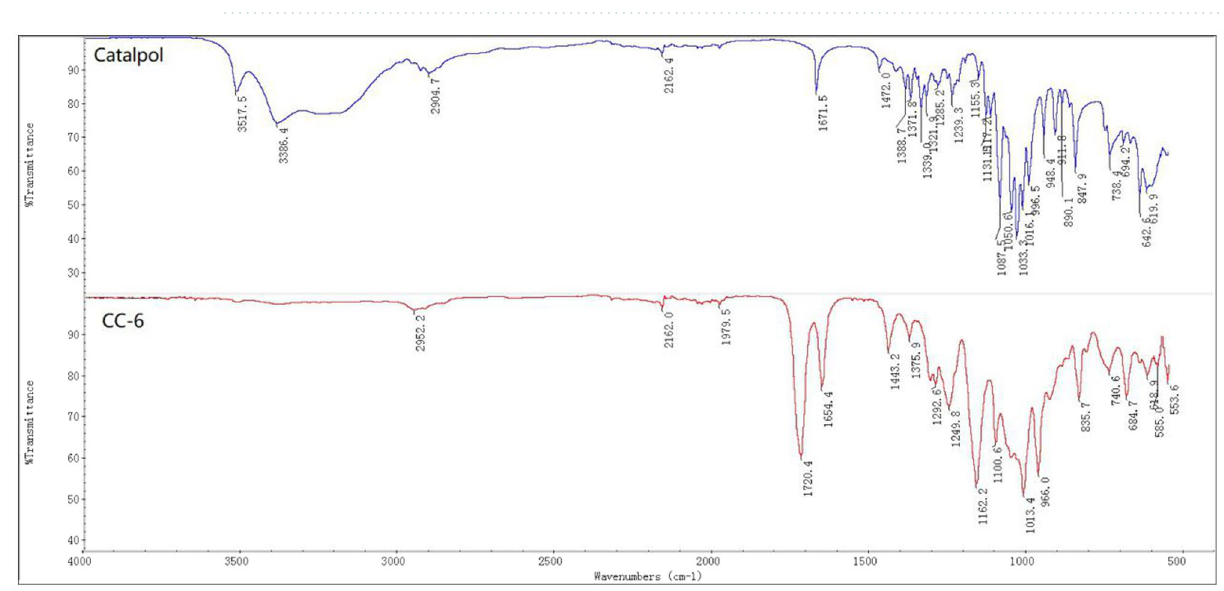
Figure 4. FT-IR spectra of catalpol ( a ) and CC-6 ( b